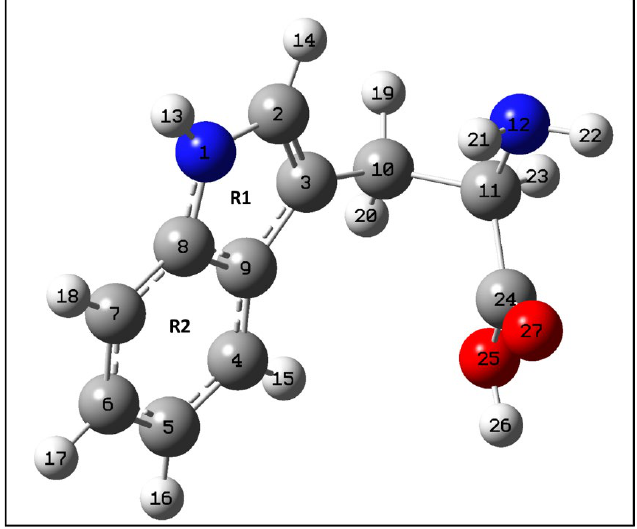
Figure A1. Optimized structure of tryptophan calculated at the B3LYP/6-311++G (d,p) level of theory. As defined in Figure 4, red represents Oxygen, blue is Nitrogen, grey is Carbon and white- Hydrogen atom.